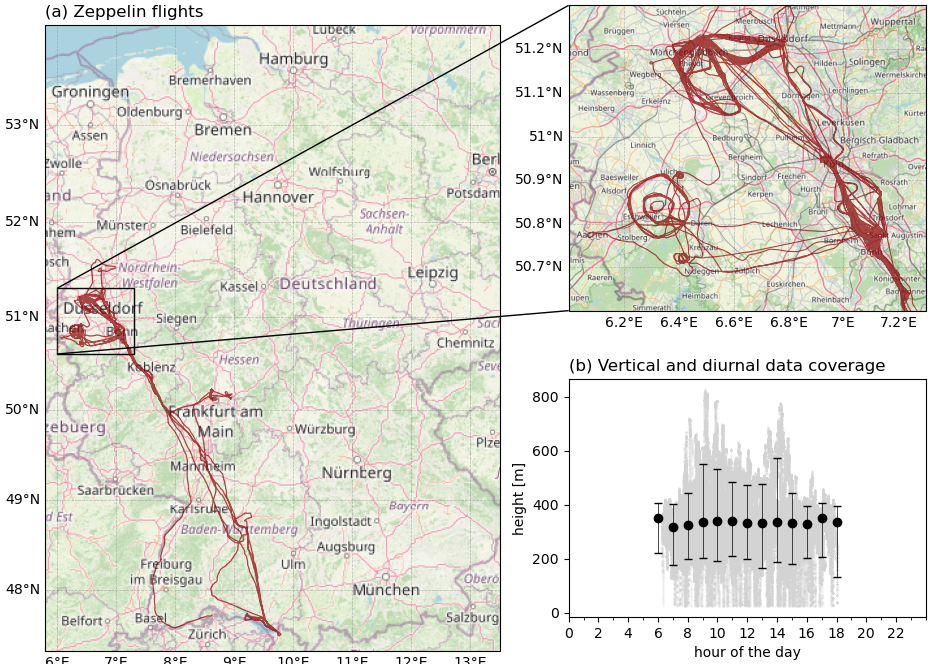
Figure 1. (a) The Zeppelin flight tracks over Germany (© OpenStreetMap contributors 2021. Distributed under the Open Data Commons Open Database License (ODbL) v1.0.) and (b) their vertical and diurnal coverage in